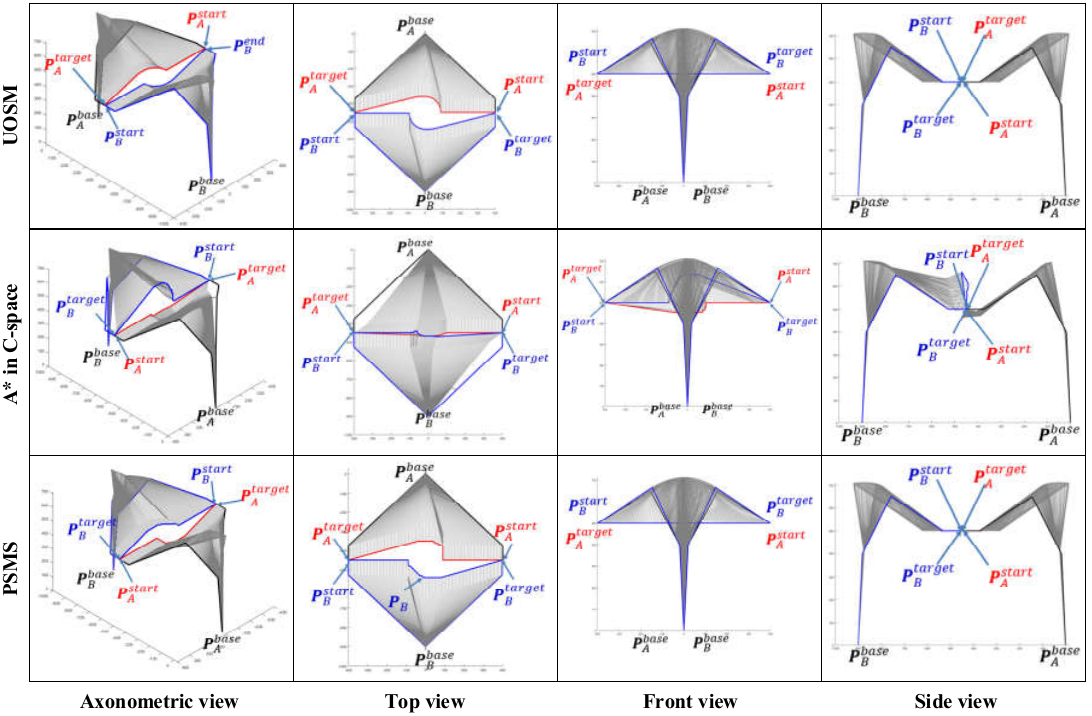
Figure 15. Comparison of simulation results of three path-planning algorithms for Case